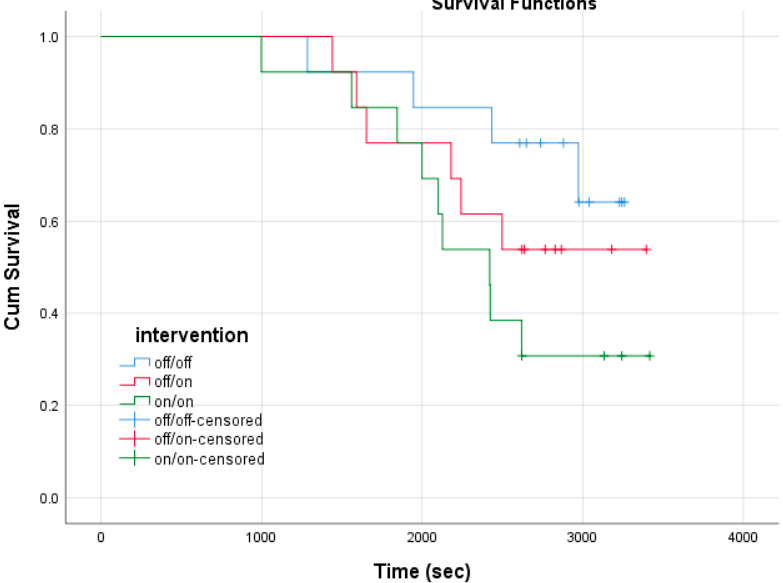
Figure 3. Kaplan–Meier survival curve across time (seconds) between wrist cooling conditions during the 10 km time trial .